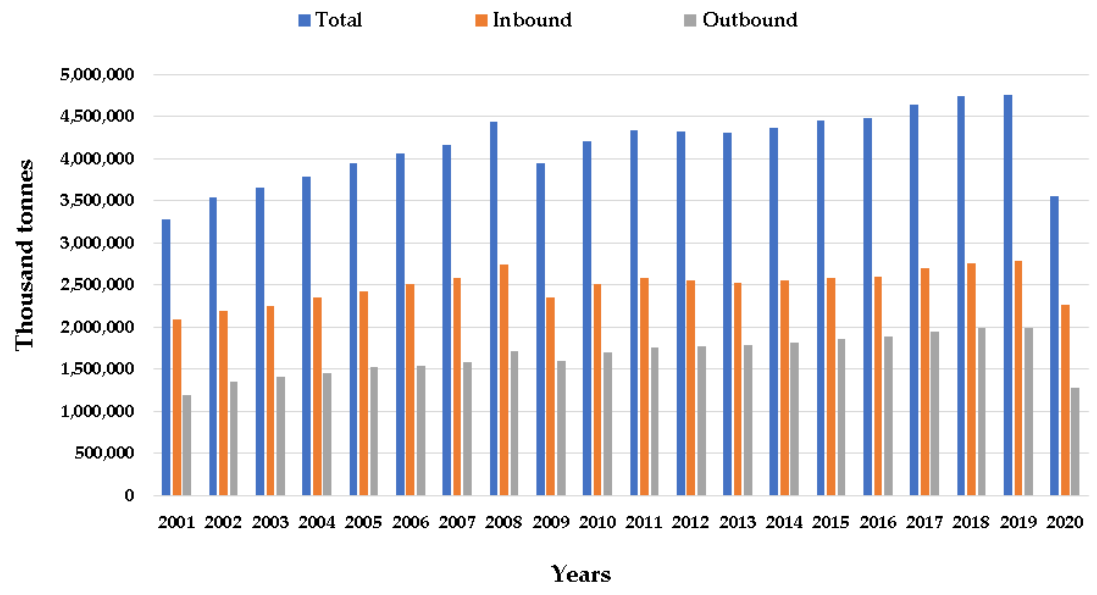
Figure 5. The gross weight of goods handled for the period